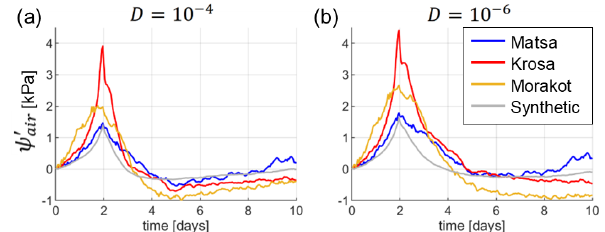
Figure A2. Atmospheric-induced pore pressures ψ (cid:48) for each ty- air phoon event in the finite hillslope model, 5m under the topogra- phy (a) at a diffusivity of 10 − 4 m 2 s − 1 and (b) at a diffusivity of 10 − 6 m 2 s − 1 . At these diffusivities, the hillslope is fully saturated from its initial state. Therefore, no rainfall effects are associated with the events, and ψ (cid:48) is the same at the toe and the crest of the air